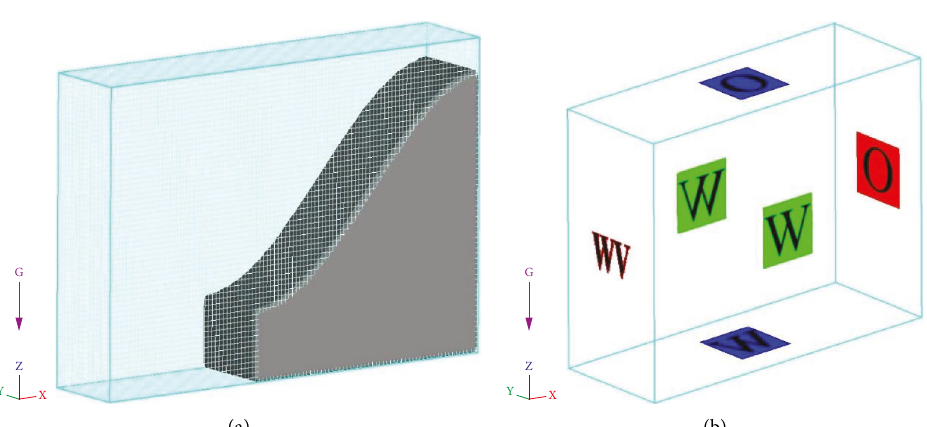
Figure 3: (a) Boundary conditions on six face blocks and (b) model mesh size of (0.015